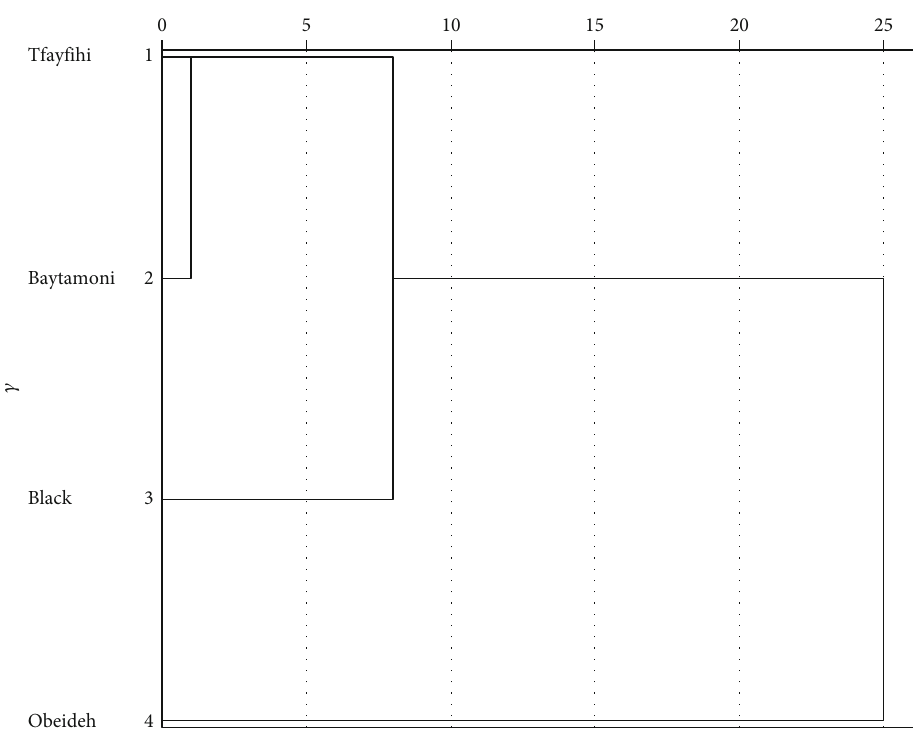
Figure 2: Cluster analysis dendrogram of the four verjuice varieties based on the studied physicochemical